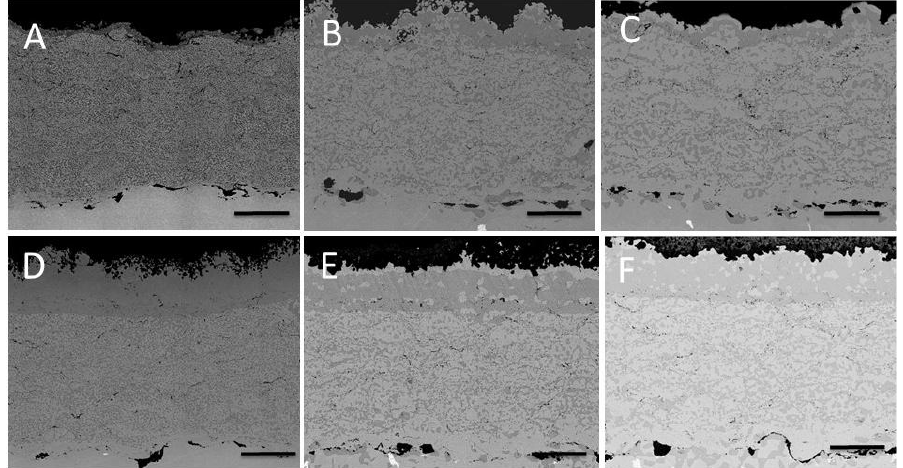
Figure 11. SEM images (BSE signal) of the over ‐ aluminized IN738 + CoNiCrAlY as function of the isothermal test duration ( A , D = 0 h; B , E = 500 h; C , F = 1000 h) for IN738 + CoNiCrAlY + pack aluminizing + heat treatment ( A – C ) and IN738 + CoNiCrAlY + IL Aluminizing + heat treatment ( D – F ). Scale bar 50 μ m.